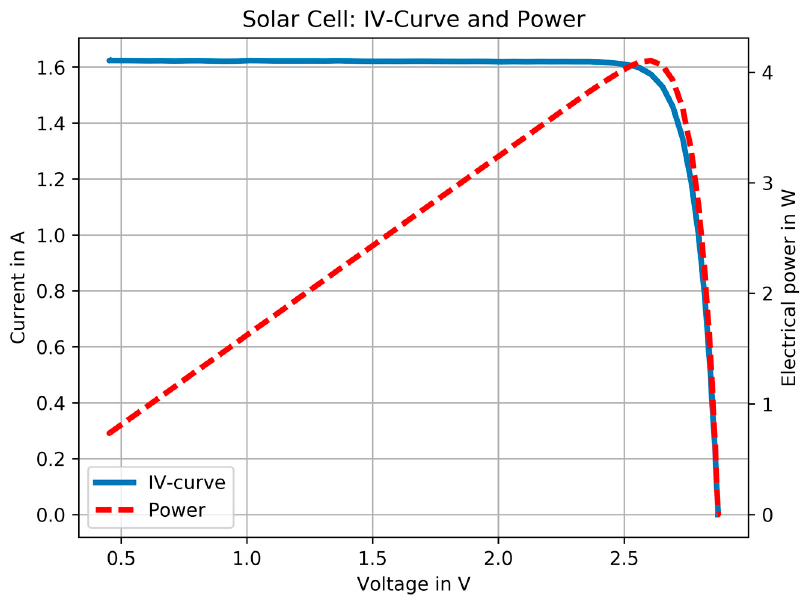
Figure 19. The temperatures (continuous lines) and the power of the solar cell (MPP; dashed line) shown over time. Due to the noon time there is less sun movement. This was used to change the temperature under similar conditions. It can be seen that the temperature difference between cell and